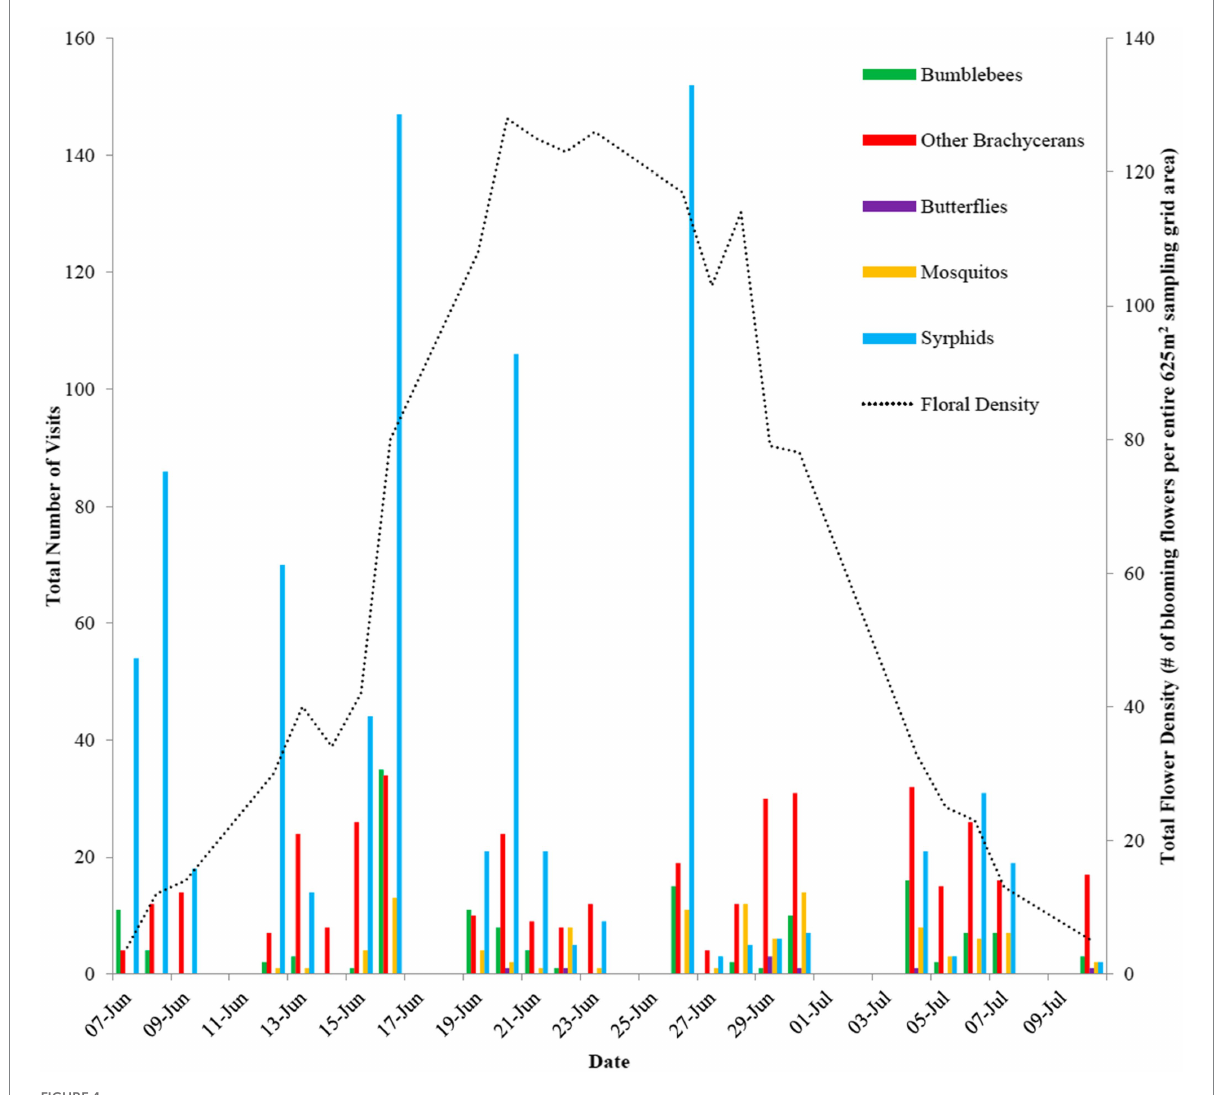
FIGURE 4 The changes in pollinator visits and flower density within the sampling grid across the entire observation